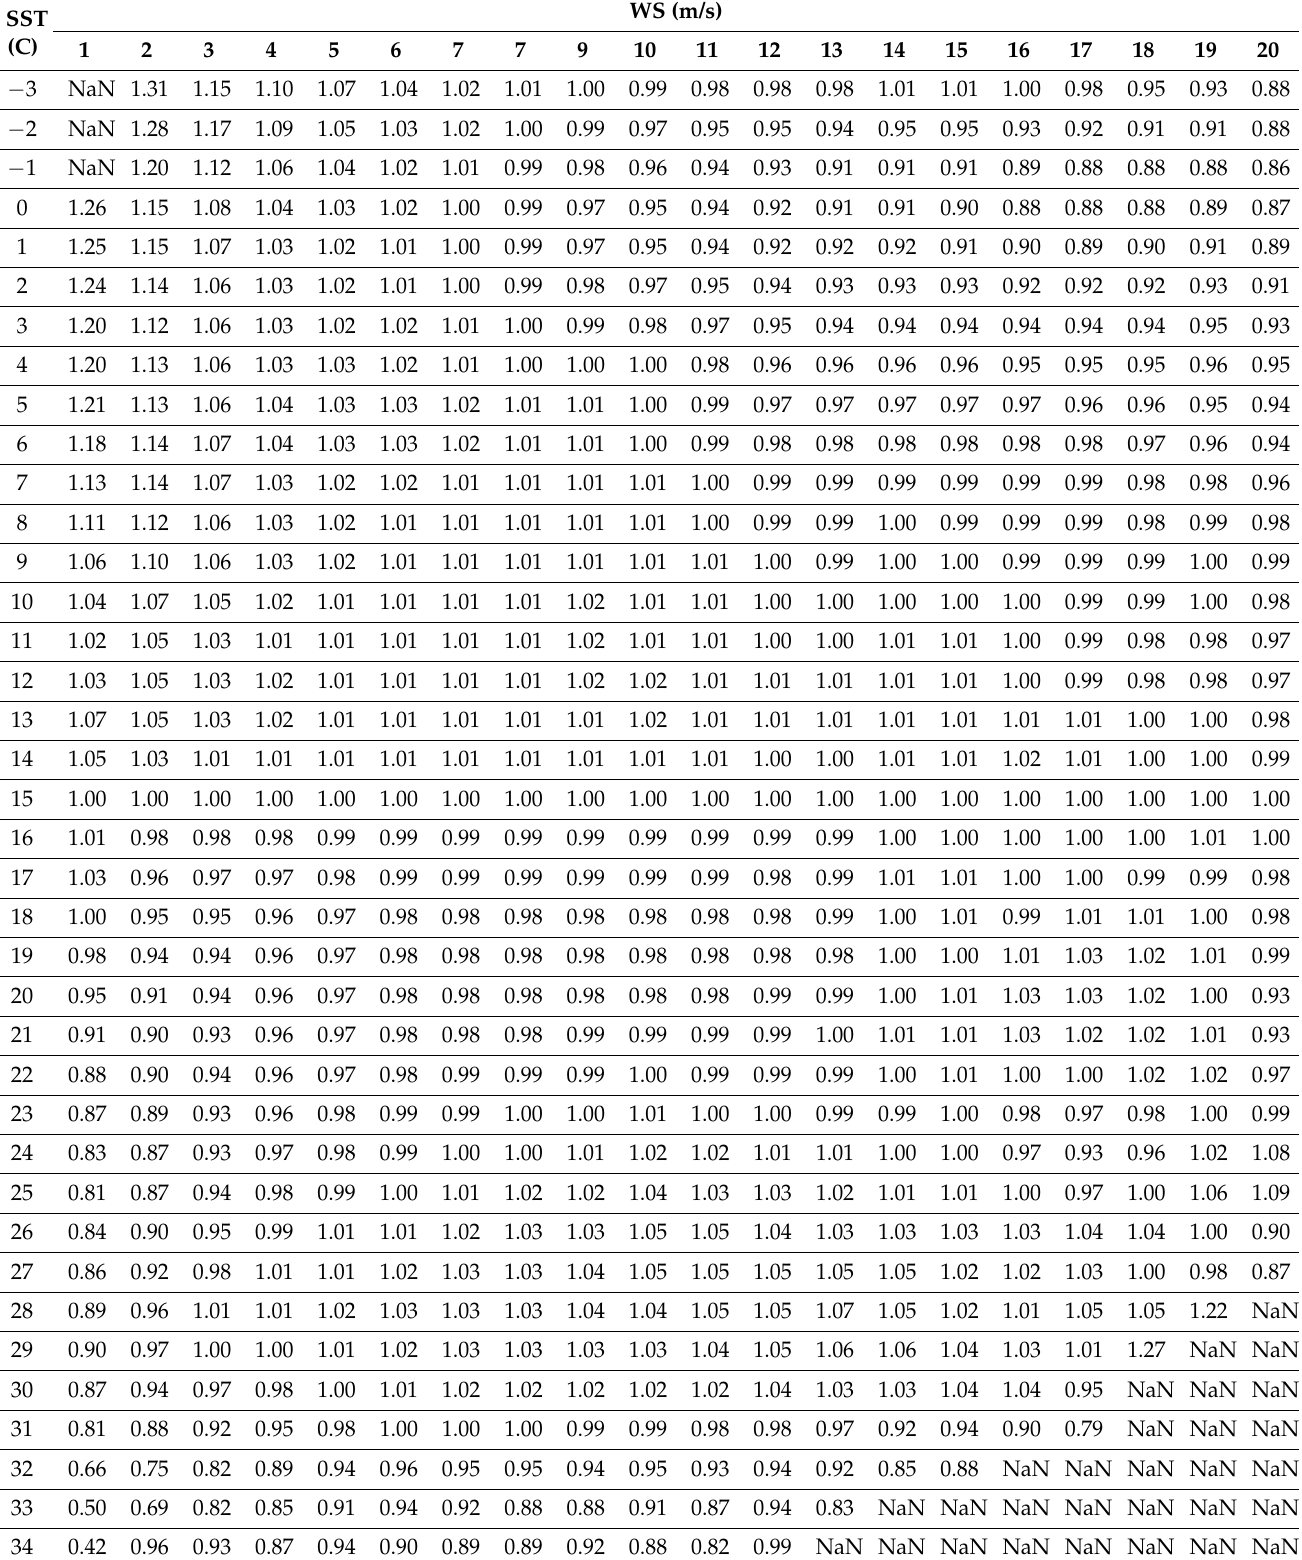
Table A5. SST correction factor (W) for Ku-band model for EIA = 18 ◦ in linear unit (Equation (8)). The bins with inadequate observations are shown as not-a-number